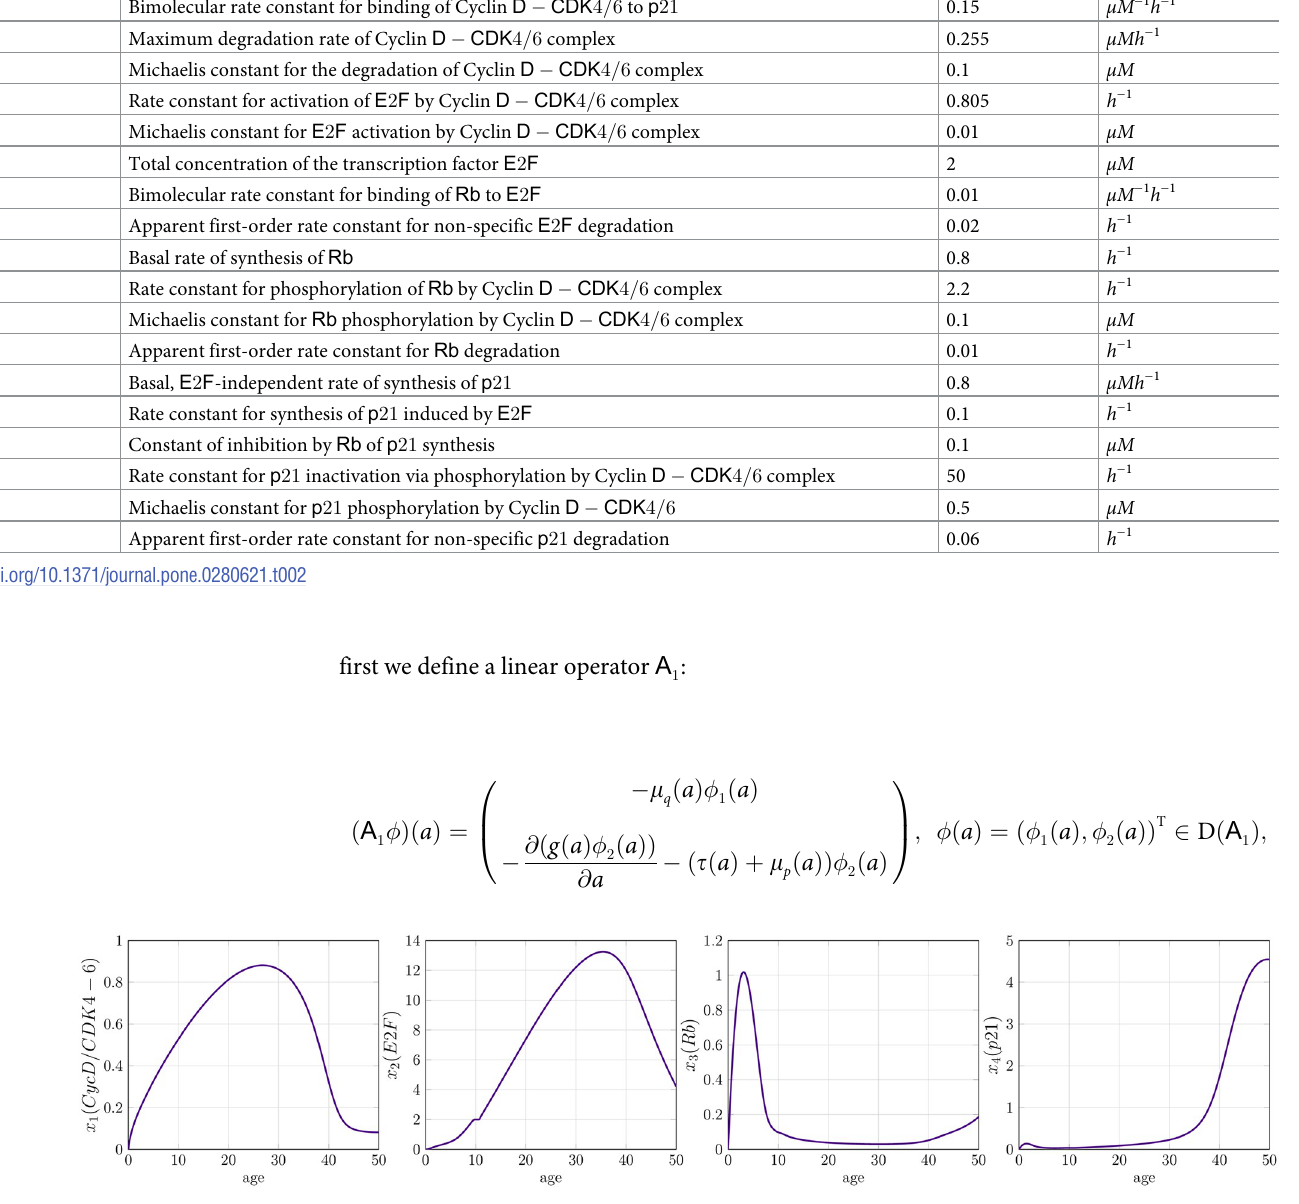
Fig 2. Evolution of microscale proteins from the cell-cycle. Cyclin D (cid:0) CDK 4 = 6 shows a complete activation and degradation within a full cycle. The concentration of transcription factor E 2 F is elevated since Retinoblastoma protein Rb is inactivated with the rise in Cyclin D (cid:0) CDK 4 = 6 complex. Similarly, protein p 21 elevates near the end of the cell-cycle to help in the degradation of the Cyclin’